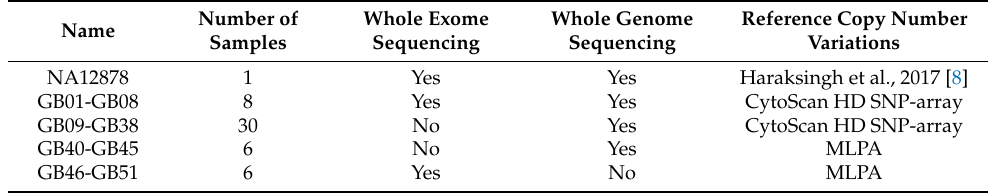
Table 1. Datasets used in this benchmark